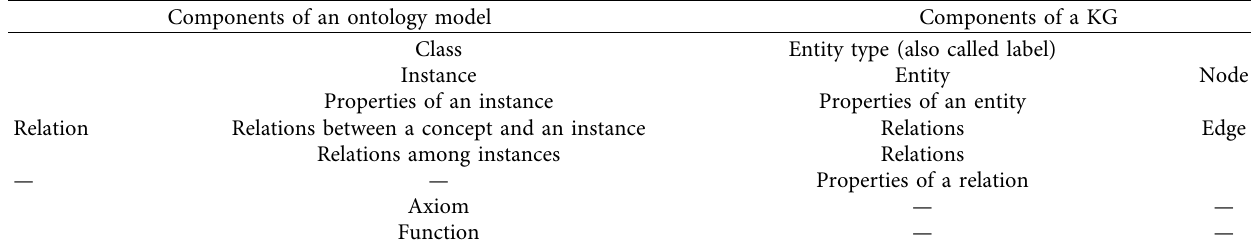
Table 1: Corresponding relationships between an ontology model and a KG.